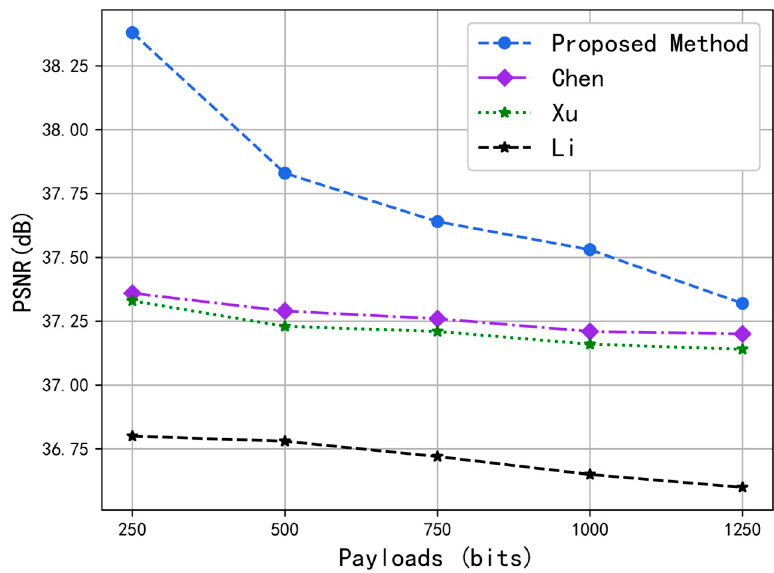
Figure 8. Comparison of PSNR values of different schemes on Foreman.